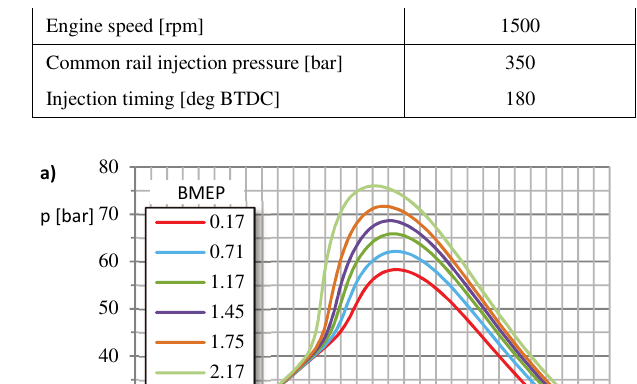
Table 4. Engine adjustment parameters for very early injection timing of Jet A-1 fuel